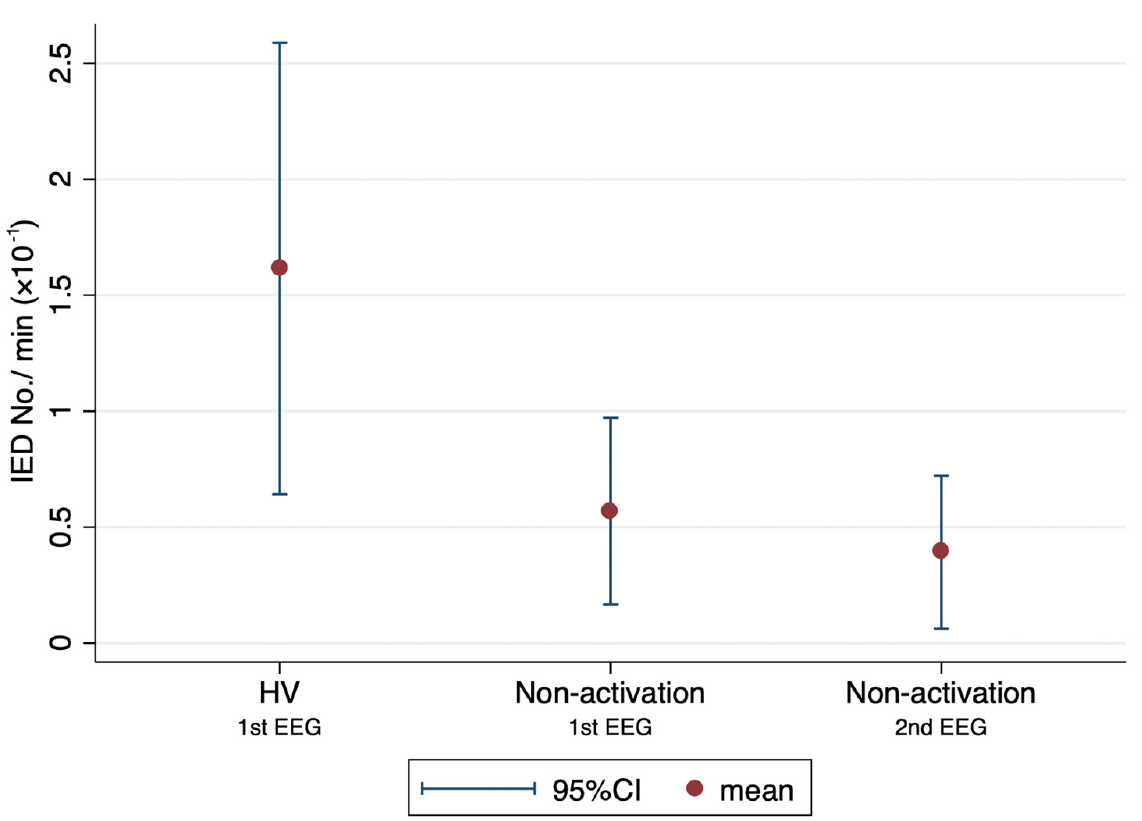
Figure 4. Mean number of IEDs/min limited to HV or non-activation. Dots and bars represent mean and 95% confidence interval (CI), respectively. Mean number of IEDs/min limited to HV was 1.61 × 10 − 1 (95%CI, 0.64–2.59 × 10 − 1 ) and that limited to non-activation was 0.57 × 10 − 1 (95%CI, 0.17–0.97 × 10 − 1 ) at first EEGs and 0.39 × 10 − 1 (95%CI, 0.06–0.72 × 10 − 1 ) at second EEGs. Number of IEDs/min